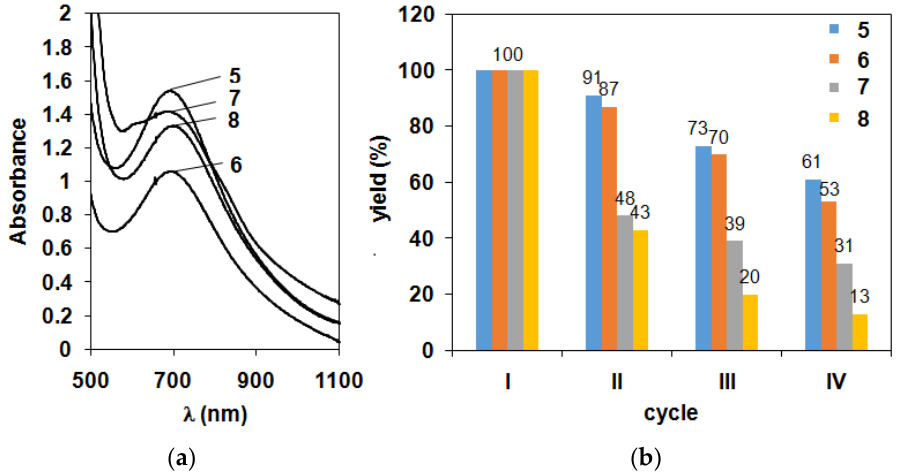
Figure 1. ( a ) Characteristic UV-Vis spectra of Fe III2 ( μ -O)( μ -1,2-O 2 )(L 1–4 ) 2 (Solv) 2 ] 2+ ( 5 – 8 ) intermediates in CH 3 CN. ( b ) Dependence of the yield of peroxo complexes ( 5 – 8 ) on the number of cycles. [Fe] 0 = 2 mM, [H 2 O 2 ] 0 = 24 mM (4x) in CH 3 CN at 20 °C. Table 1. Dependence of the yield of peroxo complexes ( 5 – 8 ) and the evolved oxygen (parantheses) on the number of cycles. [Fe] 0 = 2 mM, [H 2 O 2 ] 0 = 24 mM (4×) in CH 3 CN at 20 °C . Cycles Yield (5) and (O 2 )/% Yield (6)/% Yield (7)/% Yield